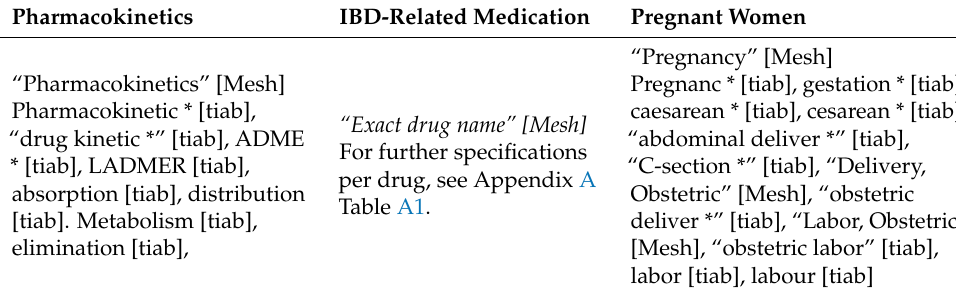
Table 1. Key terms with corresponding field used in the search